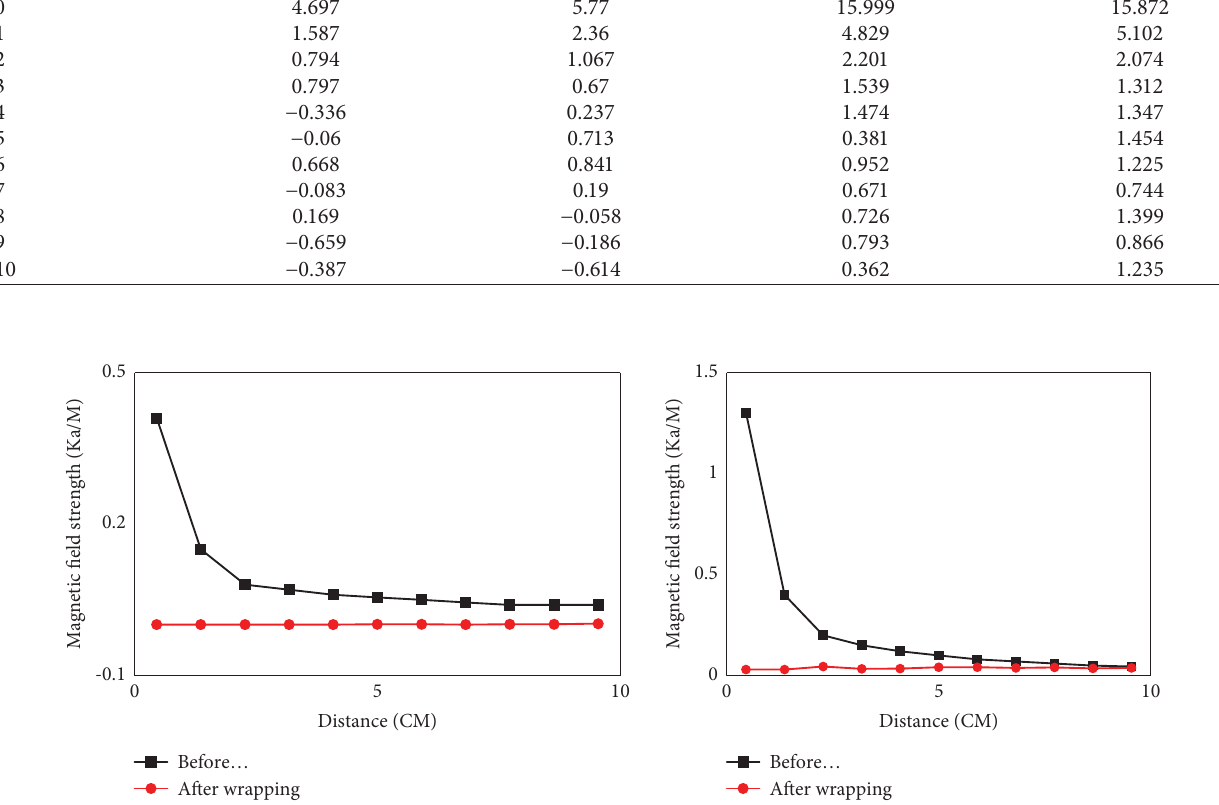
Figure 9: Variation of the magnetic field along x -axis and y